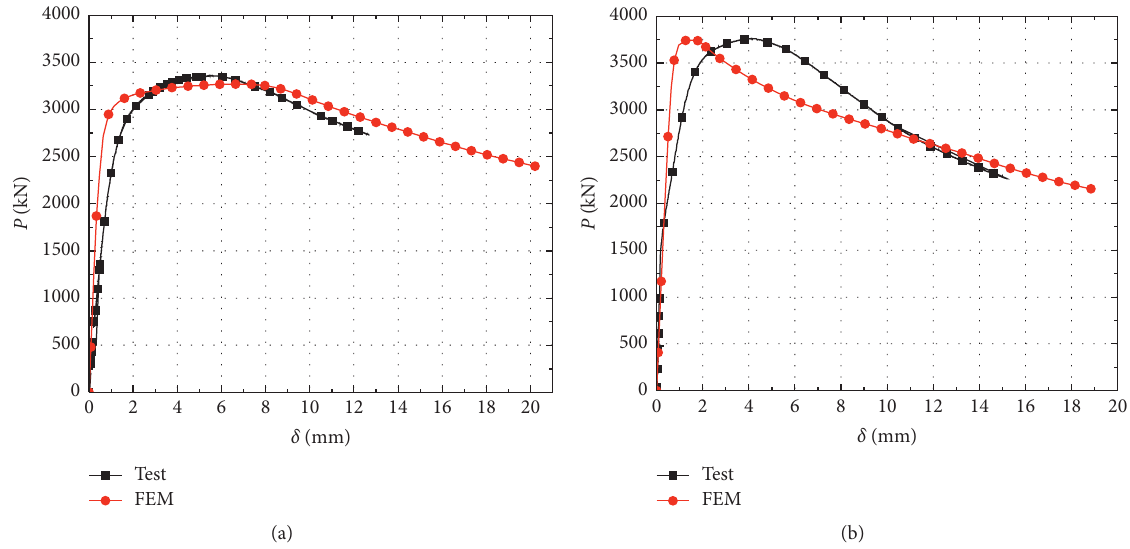
Figure 13: Comparison on load-deformation curves of some axially compressed specimens. (a) Specimen II-A-3. (b) Specimen